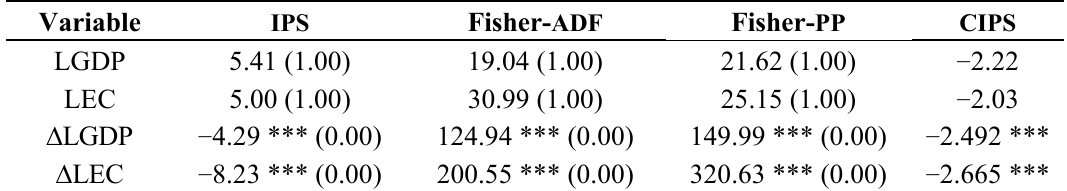
Figure 1. Energy consumption, GDP and energy intensity for 37 industrial sectors in China. Table 3. Panel unit root